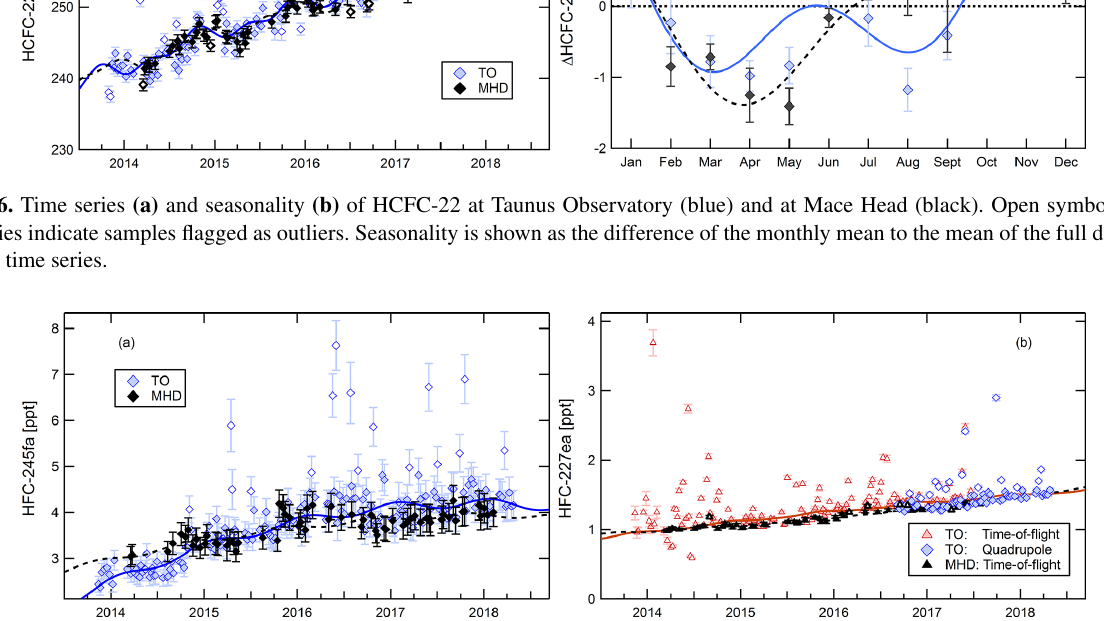
Figure 7. Time series of HFC-245fa (a) and of HFC-227ea (b) at Taunus Observatory (coloured symbols) and Mace Head (black symbols). HFC-227ea measurements were performed with the time-of-flight mass spectrometer (coloured diamonds); for comparison, data from the quadrupole mass spectrometer (coloured triangles) are shown in addition. Solid lines represent a second-order polynomial harmonic fit to the Taunus Observatory baseline dataset. Open symbols denote samples flagged as outliers at Taunus